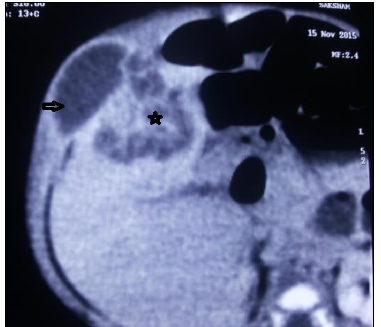
Figure 3: Case 2- CT scan showing hepatic abscess (asterisk) with extension to abdominal wall (arrow).